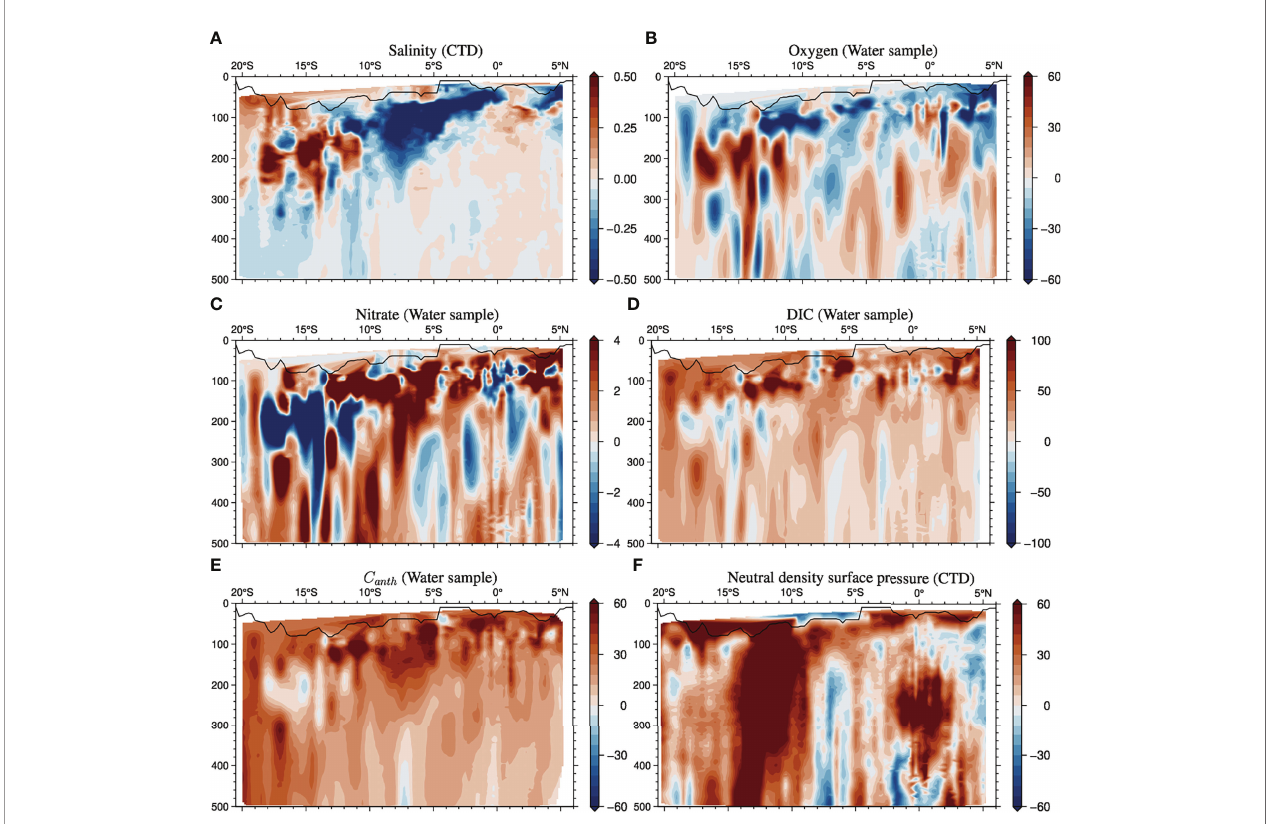
FIGURE 3 | Same as Figures 2A – E , but for changes (from September 1995 to December 2019) on isopycnal surfaces. The changes in isopycnal surface depth is shown in (F) . To project the changes on isopycnal surfaces to isobar surfaces, the mean isopycnal surface depths in two cruises (September 1995 and December 2019) were used. Mixed layer depths de fi ned as those with densities denser than 0.125 kg m -3 at 10 dbar, are shown with black